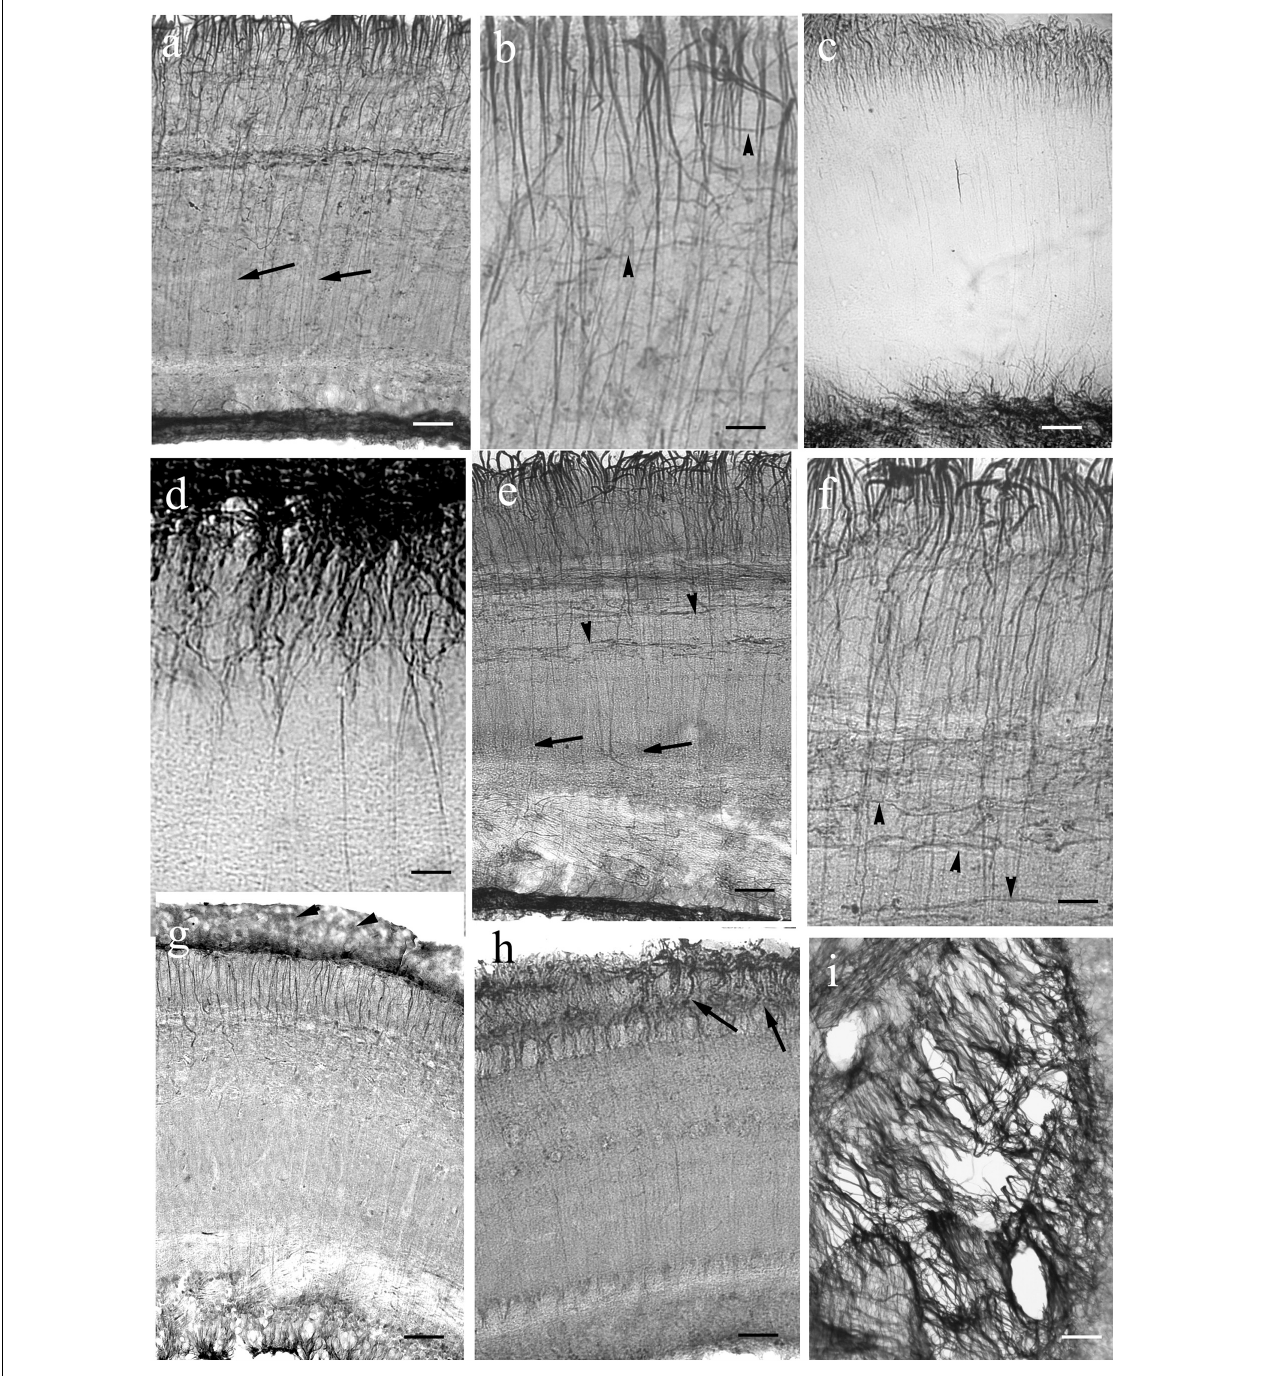
FIGURE 10 | Tectum details of Euteleostei: processes are not immunostained in full length. The meningeal surfaces are upward. The glial processes are visualized intensely only in the upper part of the section. (a) Trout. The glial processes although can be followed in the midpart of the section (arrows), but getting thinner, and disappear below. In the upper zone the processes are thick, and branching comb-like. Scale bar: 60 µ m. (b) Trout. Higher magnification reveals many thin secondary processes among them. Arrowheads: horizontal processes. Scale bar: 20 µ m. (c) Sunfish. Note the very dense submeningeal process system. Scale bar: 80 µ m. (d) Sunfish. The submeningeal system enlarged. Scale bar: 20 µ m. (e) Perch. The glial processes can be followed in the midpart of the section (arrows), but getting thinner, and disappear below; arrowheads: horizontal processes. Scale bar: 60 µ m. (f) Perch. The submeningeal system enlarged, arrowheads point to horizontal processes. Scale bar: 20 µ m. (g) Sander. Arrowheads: meningeal end-feet. Scale bar: 80 µ m. (h) Angelfish. The processes (arrows) thicken toward the meningeal surface, but the density of process system is not so conspicuous. Scale bar: 80 µ m. (i) The almost ‘bidimensional’ network of glial processes, which lines the tectum, and interconnects its two domes. Pike, tangential section. Scale bar: 15 µ m.